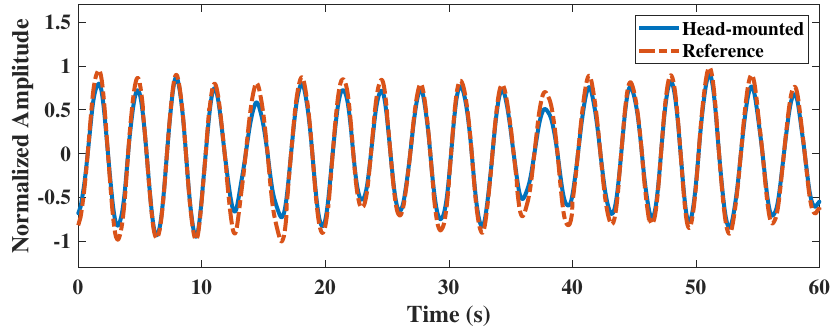
Figure 8. Comparison of respiratory waveforms measured by the two